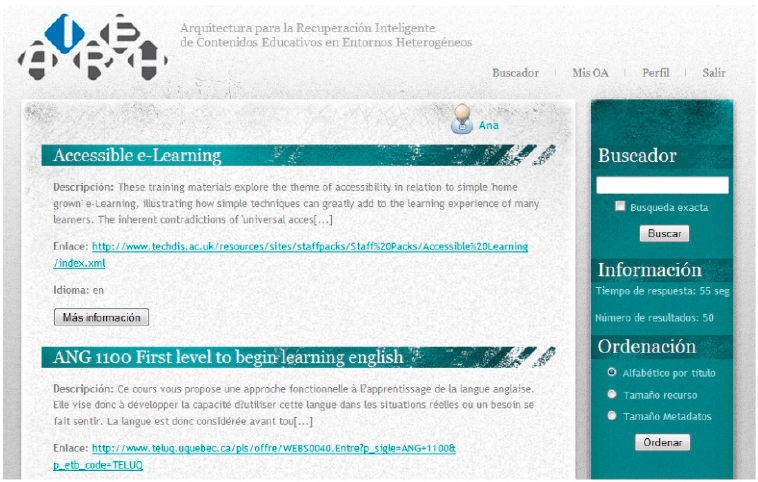
Figure 13. Sample results presentation in the User Interface (UI) AIREH